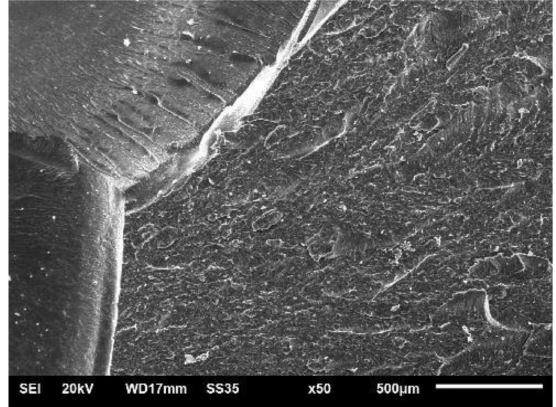
Figure 6. Topography of pure polyester resin fracture.